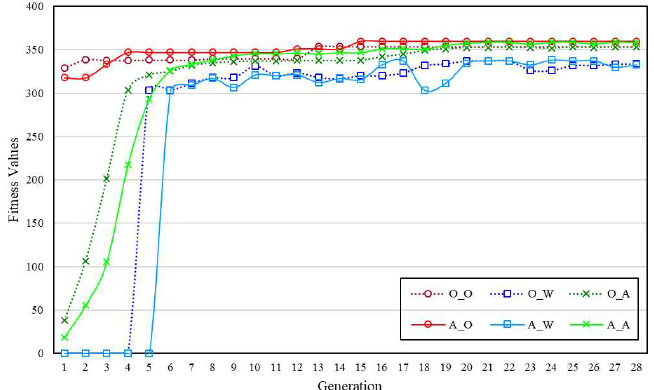
Figure 9. Compare of Traditional Crossover and Constrained Adaptive Crossover.